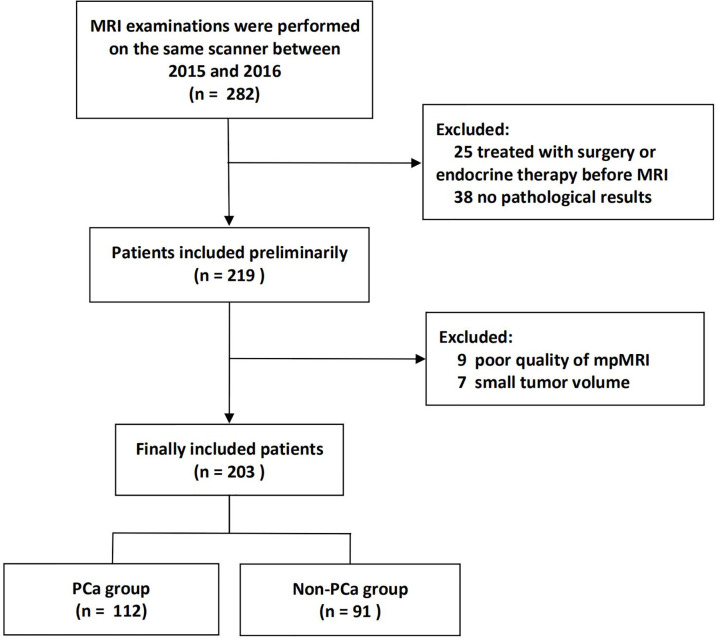
Flow chart of patients’ recruitment pathway.